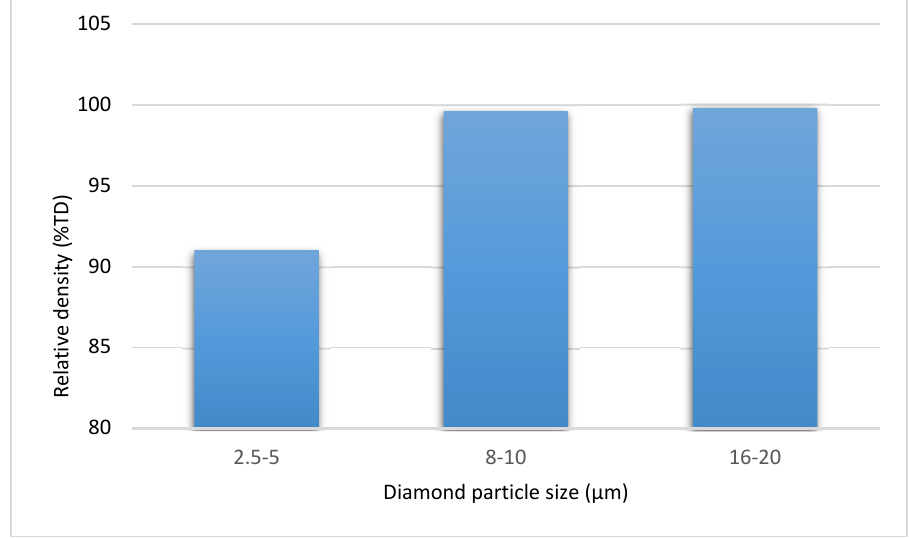
Figure 5. Impact of the diamond size on the density of the WC-Co/diamond composites. As the diamond particle size increased, the hardness of the WC-Co/diamond compo- sites increased as well. Sinters with diamond particles of 2.5–5 µm had a very low hard- ness of about 840 HV1. Sinters in which the largest diamond particles of 16–20 µm grada- tion were used had the highest hardness—2170 HV1 (Figure 6). The hardness of compo- sites containing 16–20 µm diamond particles is higher compared to WC-Co sinters ob- tained by the PPS method [32].